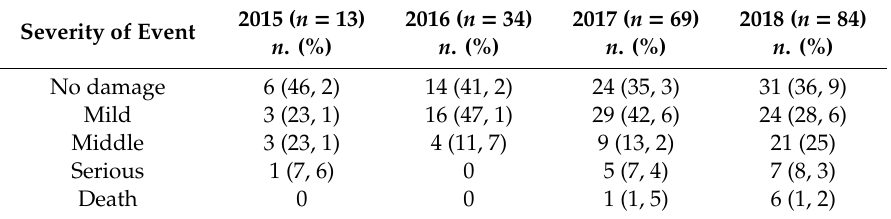
Table 6. Distribution (%) of Incident Reporting records that report the severity of the event ( n = 199), by severity and year of